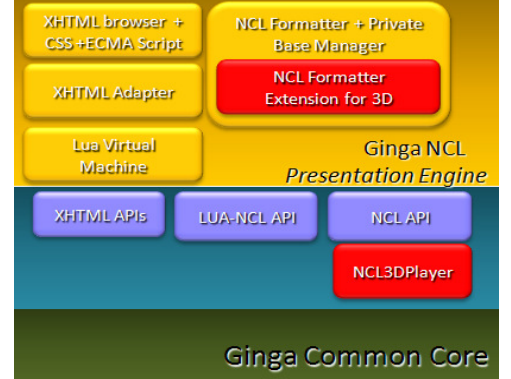
Figure 5. Incorporating a player to 3D media and extending NCL language to support 3D nodes.